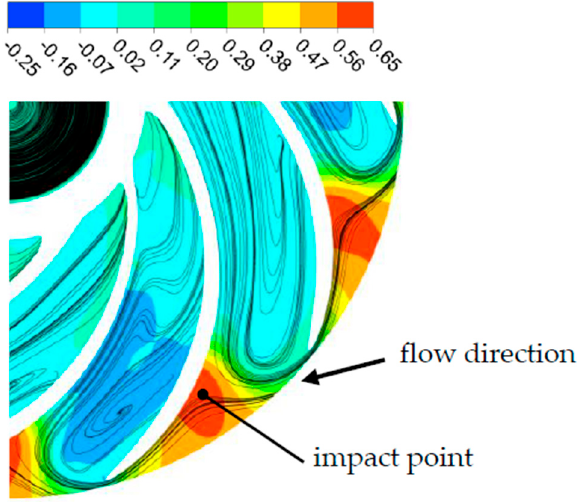
Figure 16. Pressure distribution and streamlines in the middle section of runner (Cp).